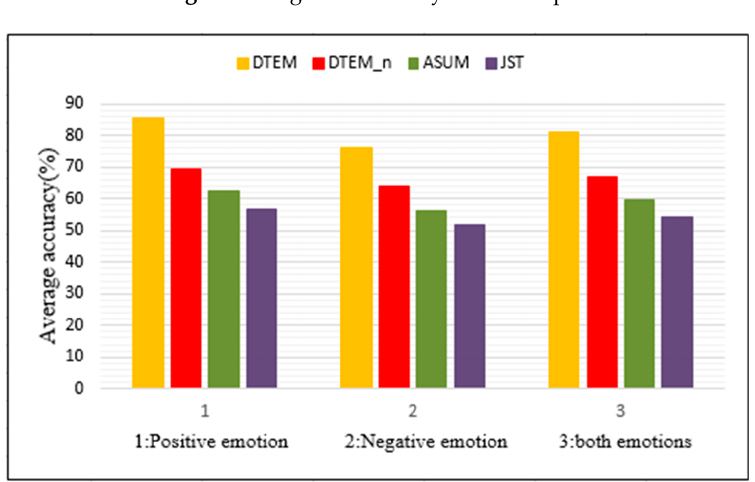
Figure 8. Negative accuracy for each topic.